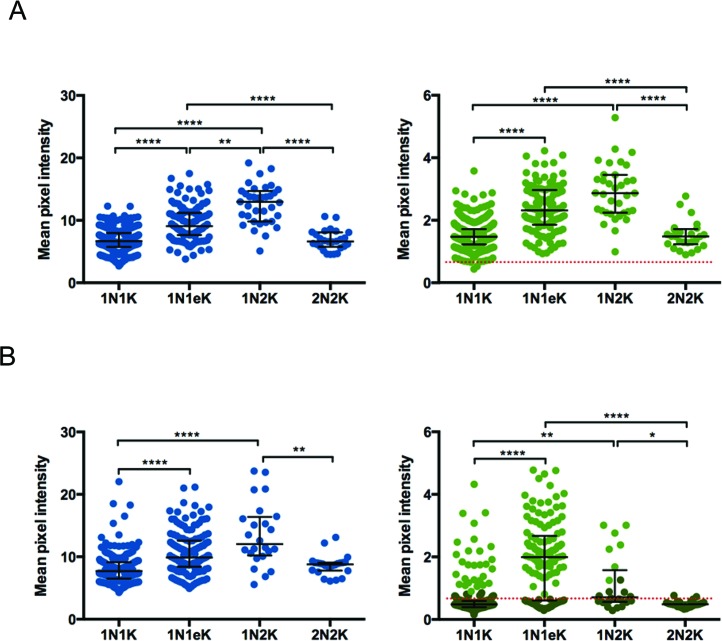
Quantification of TbORC1/CDC6 and TbORC1B subcellular localization through the cell cycle. Intensity of the DAPI (left graphs, blue dots) and myc signals (right graphs, green dots) of PCF T. brucei cells expressing TbORC1/CDC6–12myc (A) or TbORC1B-12myc (B) is represented as the mean pixel intensity within a circular ROI (21 × 21 pixels), drawn around each individual cell nucleus; for the myc signal data, the red dotted line represents the average background signal measured in 927 wt cells that do not express any tagged protein. Dark green dots represent cells in which TbORC1B-12myc signal was not visually detected, while light green dots represent cells with visually detectable TbORC1B-12myc signal. In each case, cells are separated by cell cycle stage, determined by N-K ratio in the DAPI images: 1N1K cells (G1 phase), 1N1eK cells (S phase), 1N2K cells (G2/M phase) and 2N2K cells (post-mitosis). The median values derived from the analysis of 591 TbORC1/CDC-12myc cells (1N1K – 1.47; 1N1eK – 2.31; 1N2K – 2.86; 2N2K – 1.48) and 412 TbORC1B-12myc cells (1N1K – 0.48; 1N1eK – 1.99; 1N2K – 0.71; 2N2K – 0.48) are represented, with error bars depicting the interquartile range. Statistical significance between the different cell cycle stages was assessed using the Kruskal-Wallis non-parametric test: (*) P-value < 0.05; (**) P-value < 0.01; (****) P-value < 0.0001.